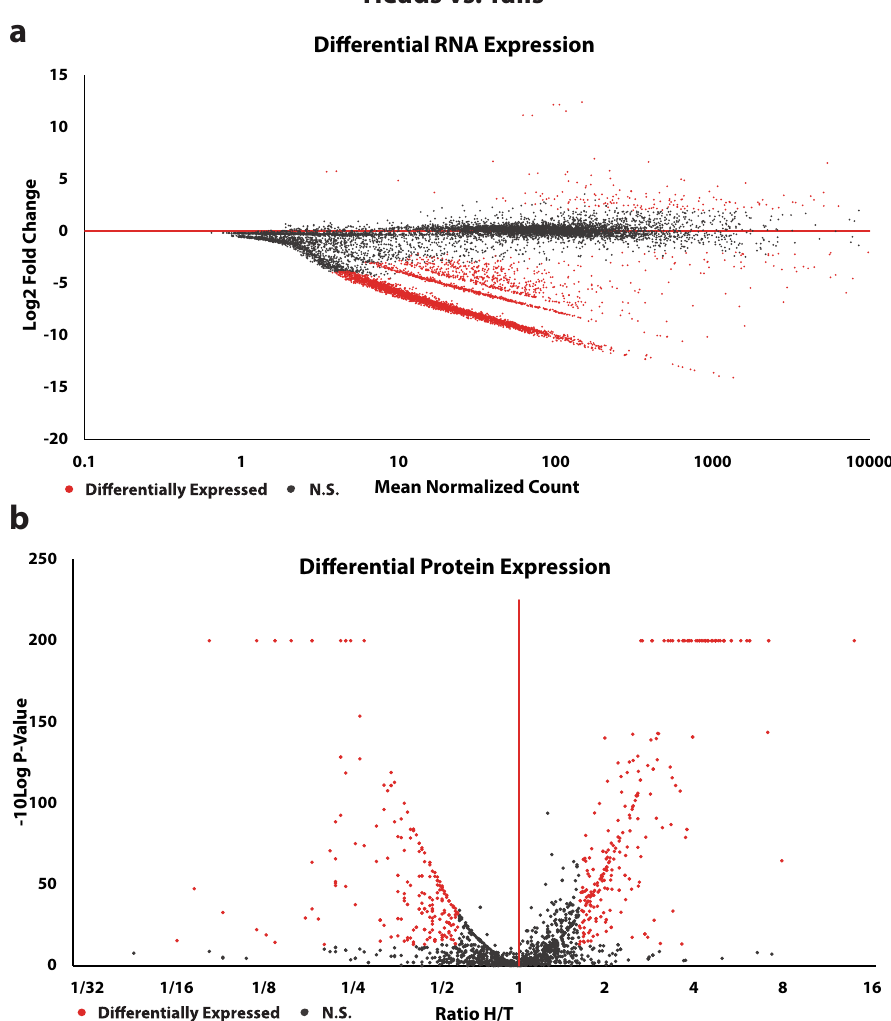
Fig. 2 Both RNA and protein are signi fi cantly differentially expressed in cercarial heads and tails. a shows the MA plot of heads compared to tails, with tails being the reference. All red dots (Differentially Expressed) are signi fi cantly upregulated transcripts with ≥ 2.0 log2 fold change and have an adjusted p - value of ≤ 0.01. All black dots (N.S.) are outside these thresholds. b shows a volcano plot of differentially expressed proteins heads and tails by the ratio (Head/Tail). All red dots (Differentially Expressed) are proteins with a ratio of ≥ 1.6 and a signi fi cance ≥ 13.0 − 10 log p -value. All black dots (N.S.) fall outside of these thresholds. All supporting data is contained in Supplementary Data 1. Replication n = 3 independent biological